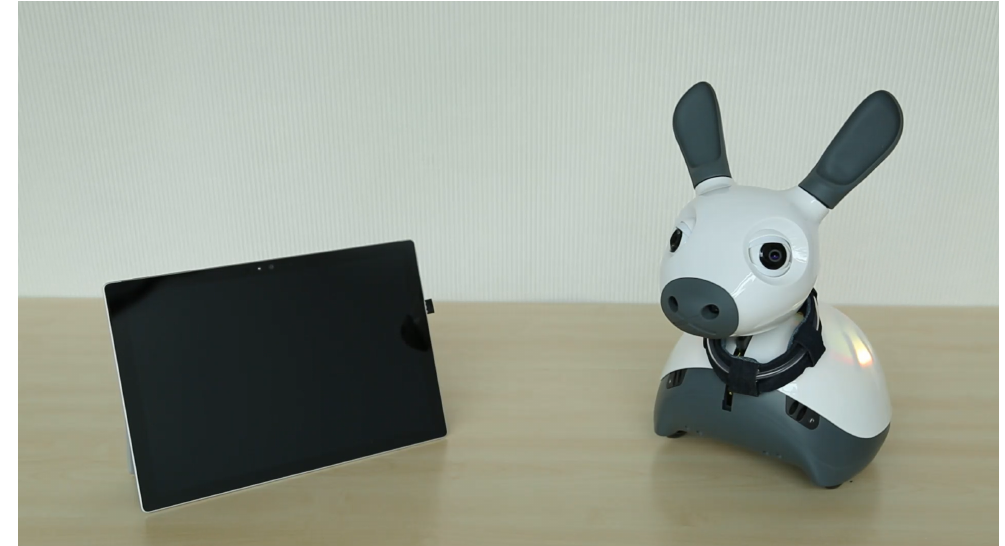
Figure 6. The animoid robot MiRo in the quiz scenario accompanied by a tablet. This setup has been used in the user study for pattern